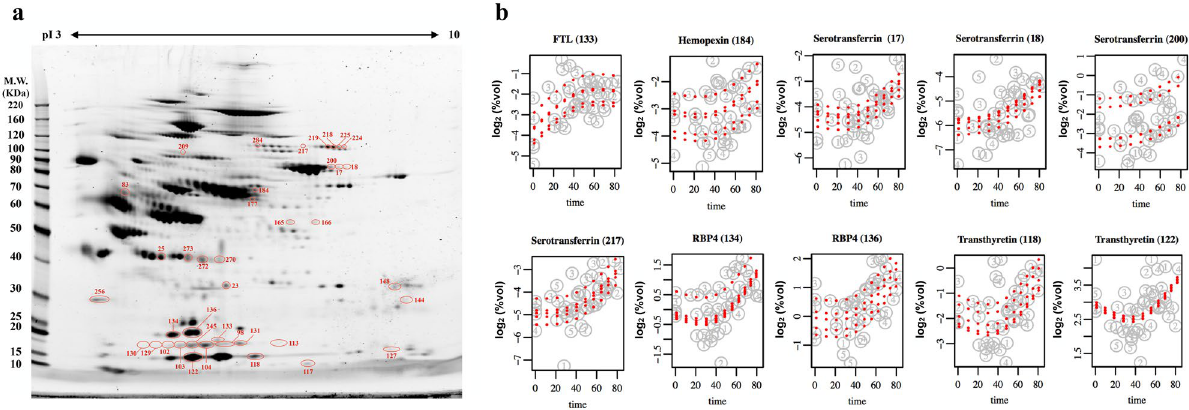
Figure 2. Proteins that changed significantly over time during HSCT. ( a ) Representative two-dimensional gel electrophoresis (2-DE) image showing positions of 39 significant spots changed over time during HSCT. These spots have FDR < 0.10 determined by the natural cubic spline model. The labels of spots reflect the match ID generated in Image Master 2D Platinum software. ( b ) Plots of significant spots. Plots are showing changes in spot %vol on 2-DE image over time in five patients. Names of proteins identified were labeled with spot numbers shown in brackets. FTL: ferritin light chain; RBP4: retinol-binding protein 4. The x-axis shows time in days, zero being the day of first serum collection, that is, before transplantation. The next time point was approximately 1 week after transplantation, and continued until the eighth week. Details on serum collection time is available in the supplementary data. The rest of the plots of significant spots can also be found in the supplementary data.